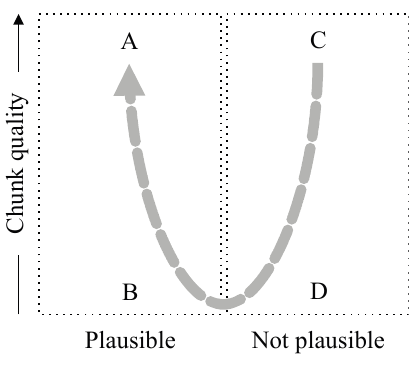
Figure 7. Plausibility and chunk quality.